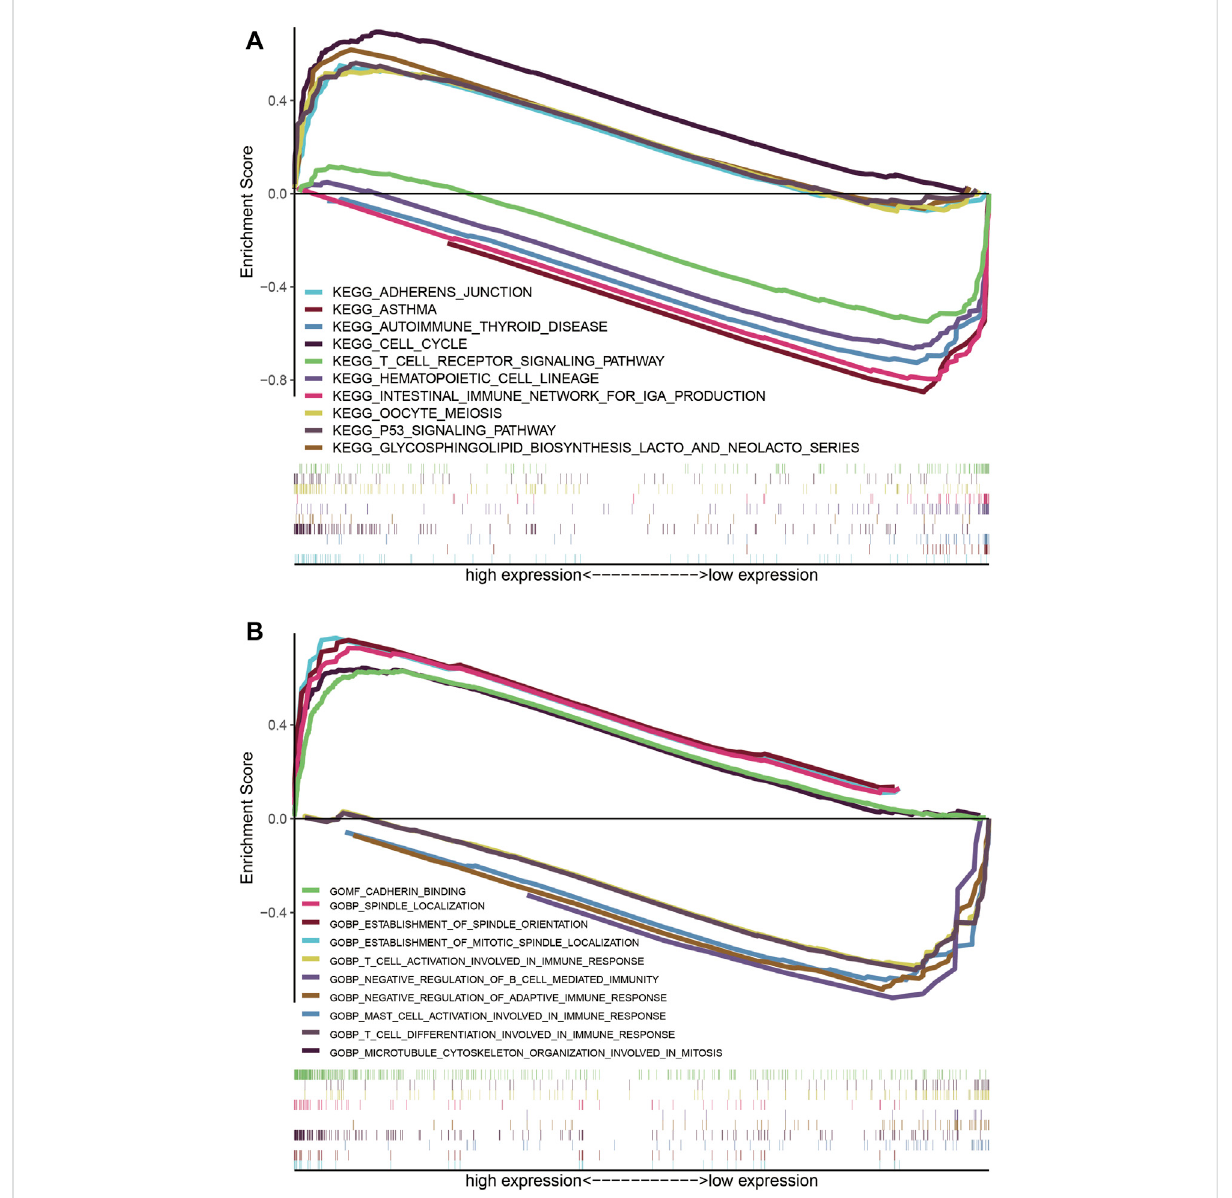
FIGURE 9 LUADSenLncSig-based GSEA of different risk groups. (A) Based on the GSEA results, the KEGG genes were differentially enriched for senescence-relatedlncRNAexpression.FiveKEGGitems,thecellcycle,p53signalingpathway,oocytemeiosis,glycosphingolipidbiosynthesis-lacto and neolacto series, and adherens junction were enriched in the high-risk group. Asthma, intestinal immune network for IgA production, hematopoietic cell lineage, autoimmune thyroid disease, and T cell receptor signaling pathway were enriched in the low-risk group based on the NES, NOM p -value, and FDR q-value (B) Differential enrichment of genes in GO with senescence-related lncRNAs. Five GO items, spindle localization, establishment of spindle orientation, establishment of mitotic spindle localization, cadherin binding, and microtubule cytoskeleton organization involved in mitosis showed a signi fi cant differential enrichment in the high expression phenotype. The other fi ve GO terms, negative regulation of adaptive immune response, mast cell activation involved in immune response, T cell activation involved in immune response, T cell differentiation involved in immune response, and negative regulation of B cell mediated immunity, were found signi fi cantly enriched in the low expression phenotype based on theNES, NOM p -value, and FDR q-value. The reference fi les from the (MSigDB) were c2. cp.kegg.v7.4. symbols.gmt and c5. go.v7.4 symbols. gmt (http://software.broadinstitute.org/gsea/msigdb/index.jsp). LncRNAs, long non-coding RNAs; LUAD, lung adenocarcinoma; LUADSenLncSig, LUAD senescence lncRNA signature; GSEA, Gene Set Enrichment Analysis; KEGG, Kyoto Encyclopedia of Gene andGenome;NES,normalizedenrichmentscore;NOM p -value,nominal p -value;FDR,falsedetectionrate;GO,GeneOntology;MSigDB,Molecular Signatures